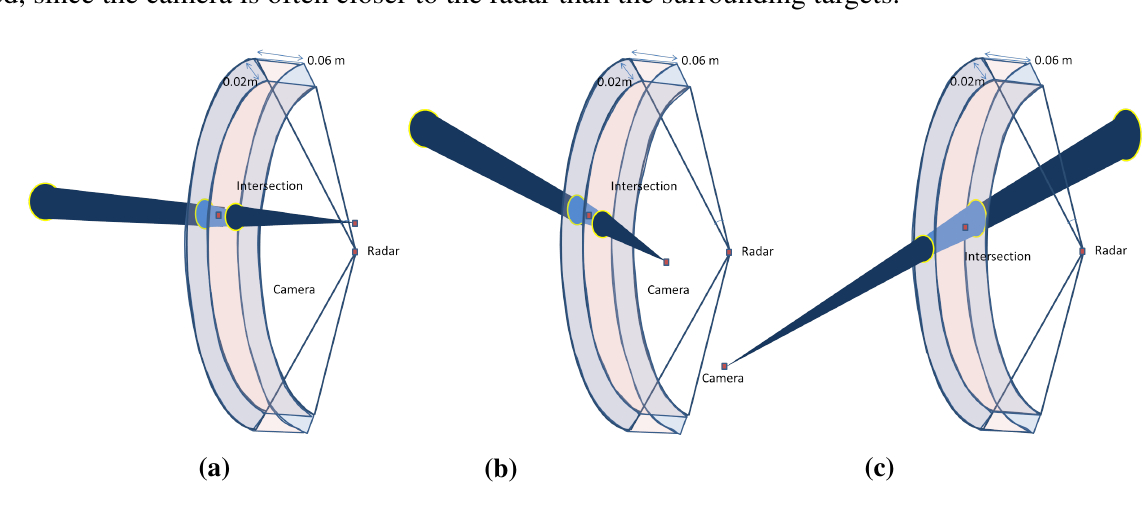
Figure 12. The effect of the baseline is illustrated. The intersection of the uncertainty regions of each sensor projection is also shown. ( a ) Short baseline; ( b ) Wide baseline; ( c ) Wide